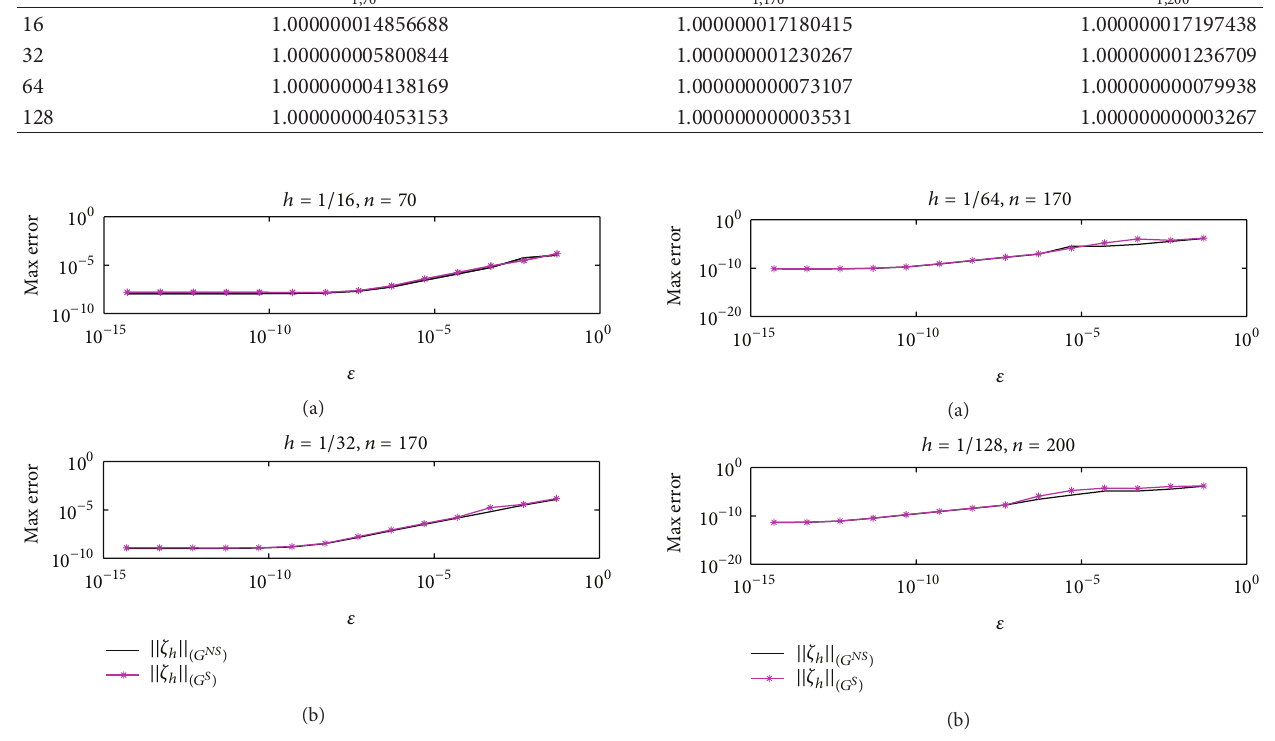
Figure 3: Dependence on 𝜀 for ℎ −1 = 16, 32 . Figure 4: Dependence on 𝜀 for ℎ −1 = 64, 128